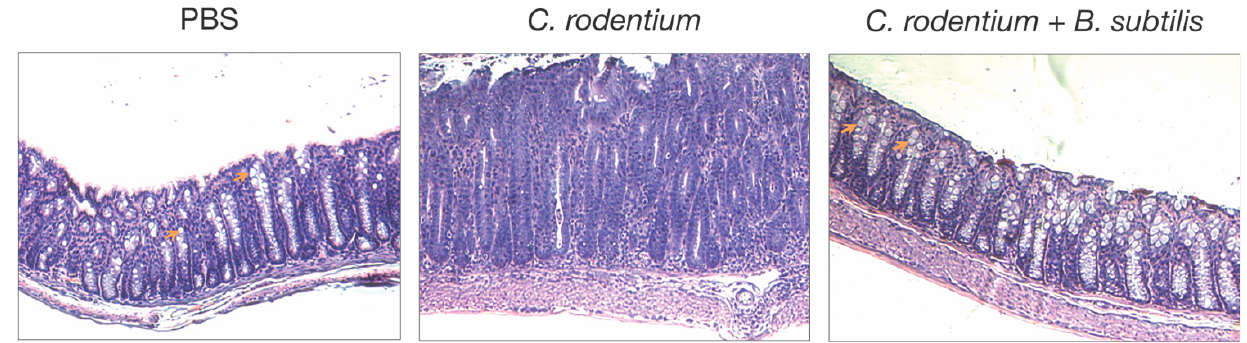
Figure 1. Colonic histological analysis of the effect of B. subtilis spores in C. rodentium disease 10 days post infection. Note goblet cells present in normal tissue (arrows), but reduced in colon infected with C. rodentium . Reprinted from [9] .